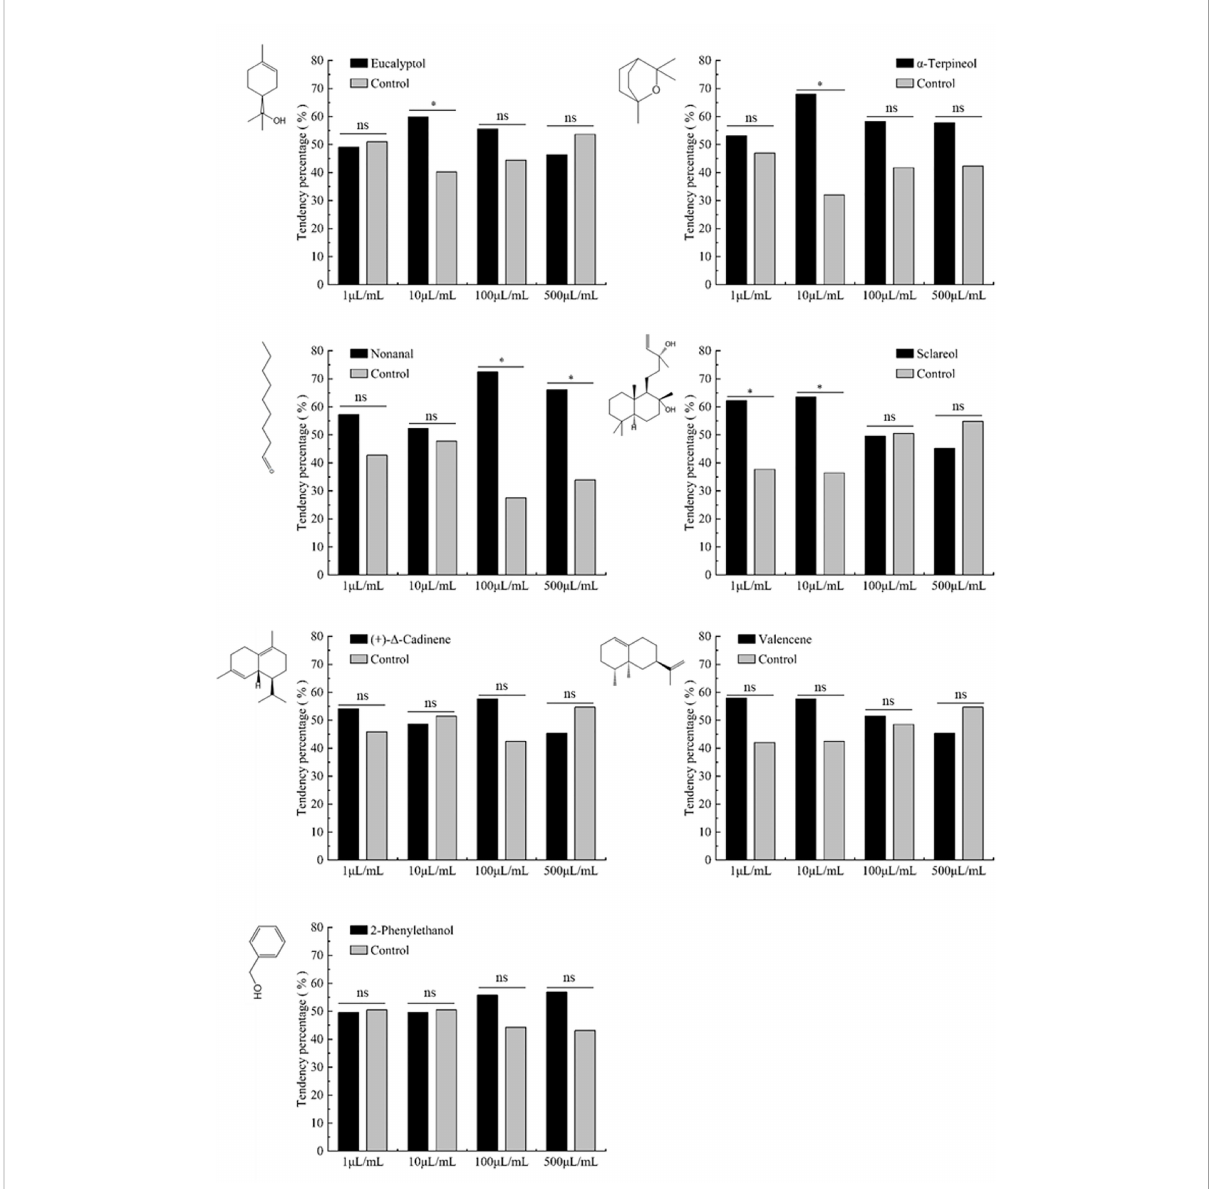
FIGURE 5 Behavioral responses of H. axyridis adults to key volatile compounds. Control for equal volume of paraf fi n liquid, Chi-square test was used between the test odor substances and the control group. “ * ” indicated that there was a signi fi cant difference in the preference of H. axyridis to the key odor substances and the control at the same concentration ( P < 0.05) while “ ns ” indicated no signi fi cant